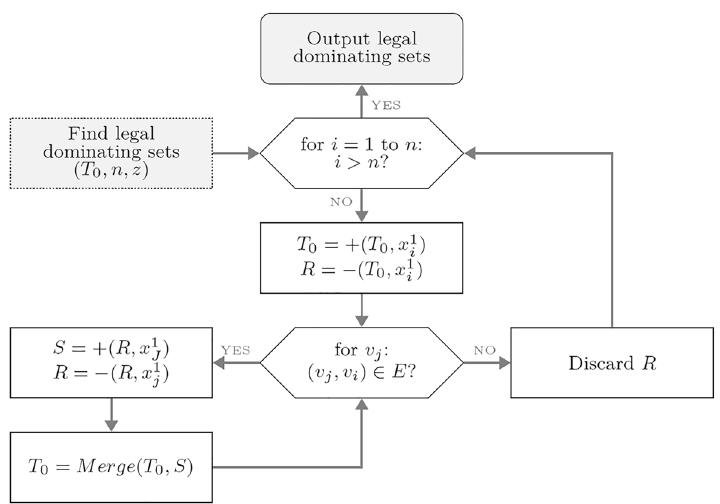
Figure 5. Biomolecular procedure for finding legal dominating